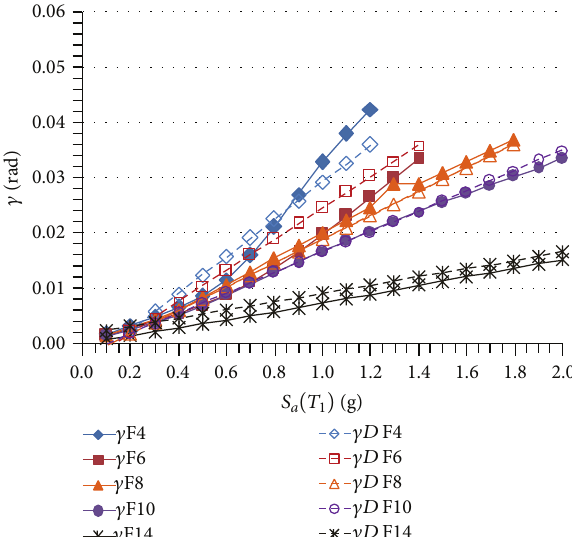
Figure 6: Maximum drift calculated for the MDOFS with